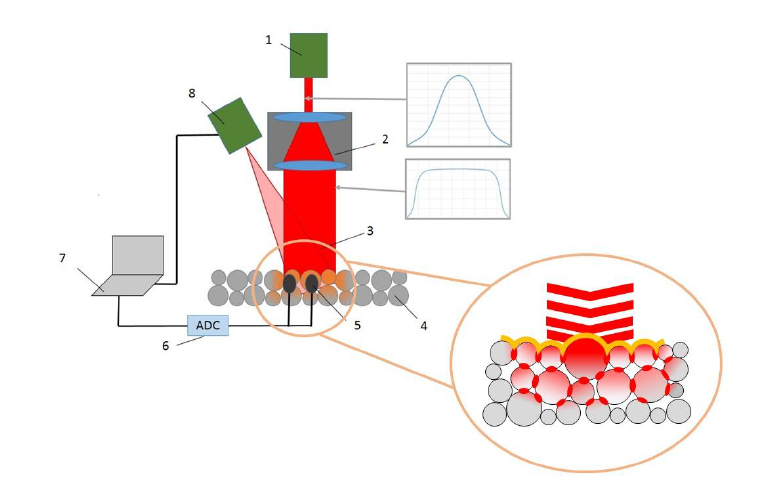
Fig. 1. Scheme for measuring the absorption of powder